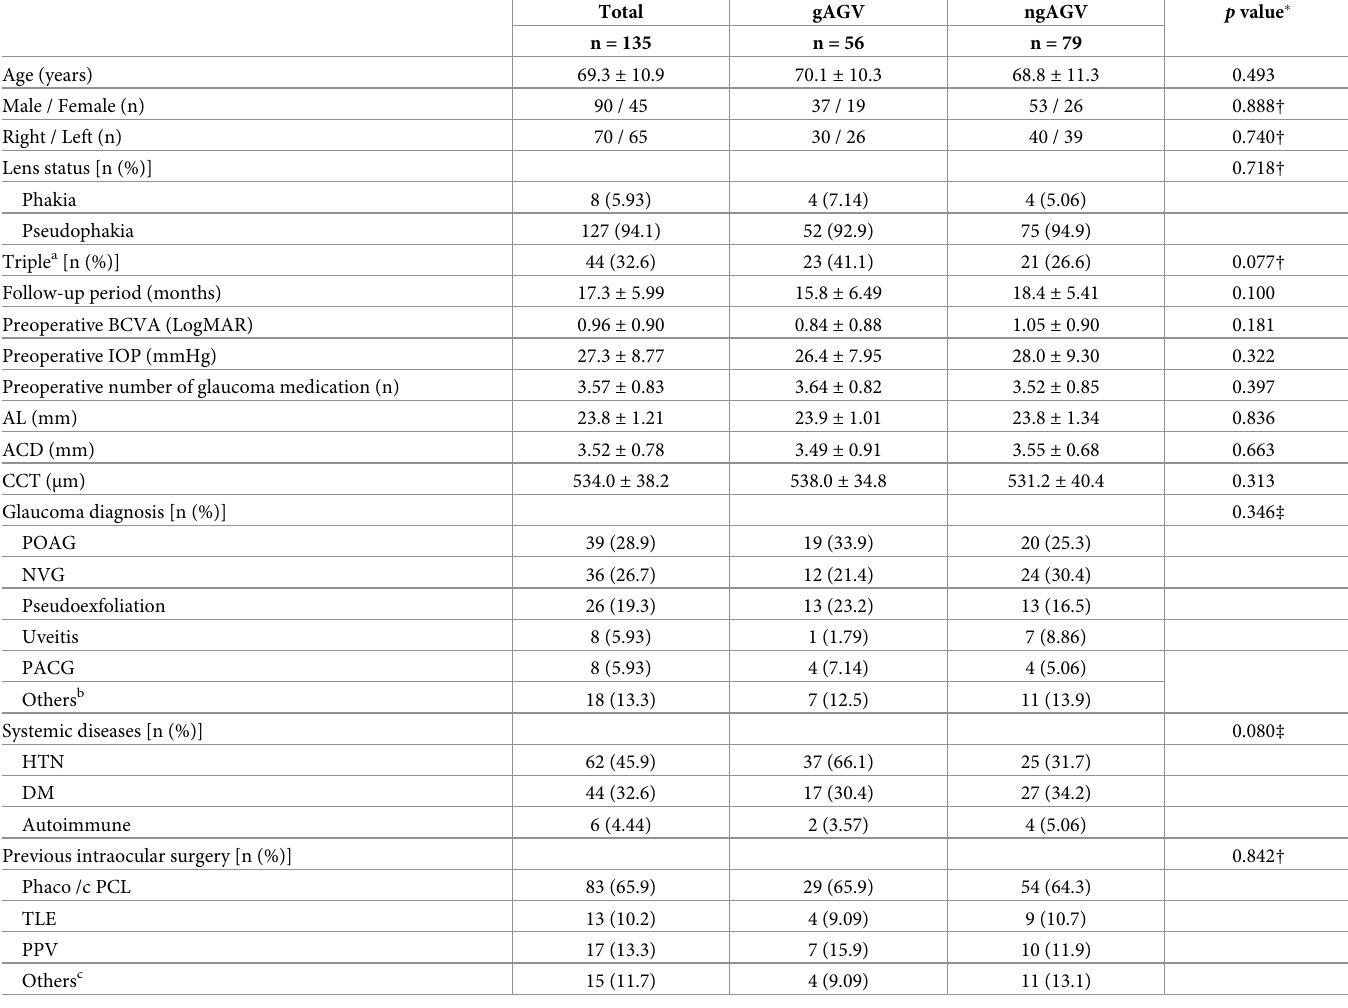
Table 1. Baseline characteristics of the